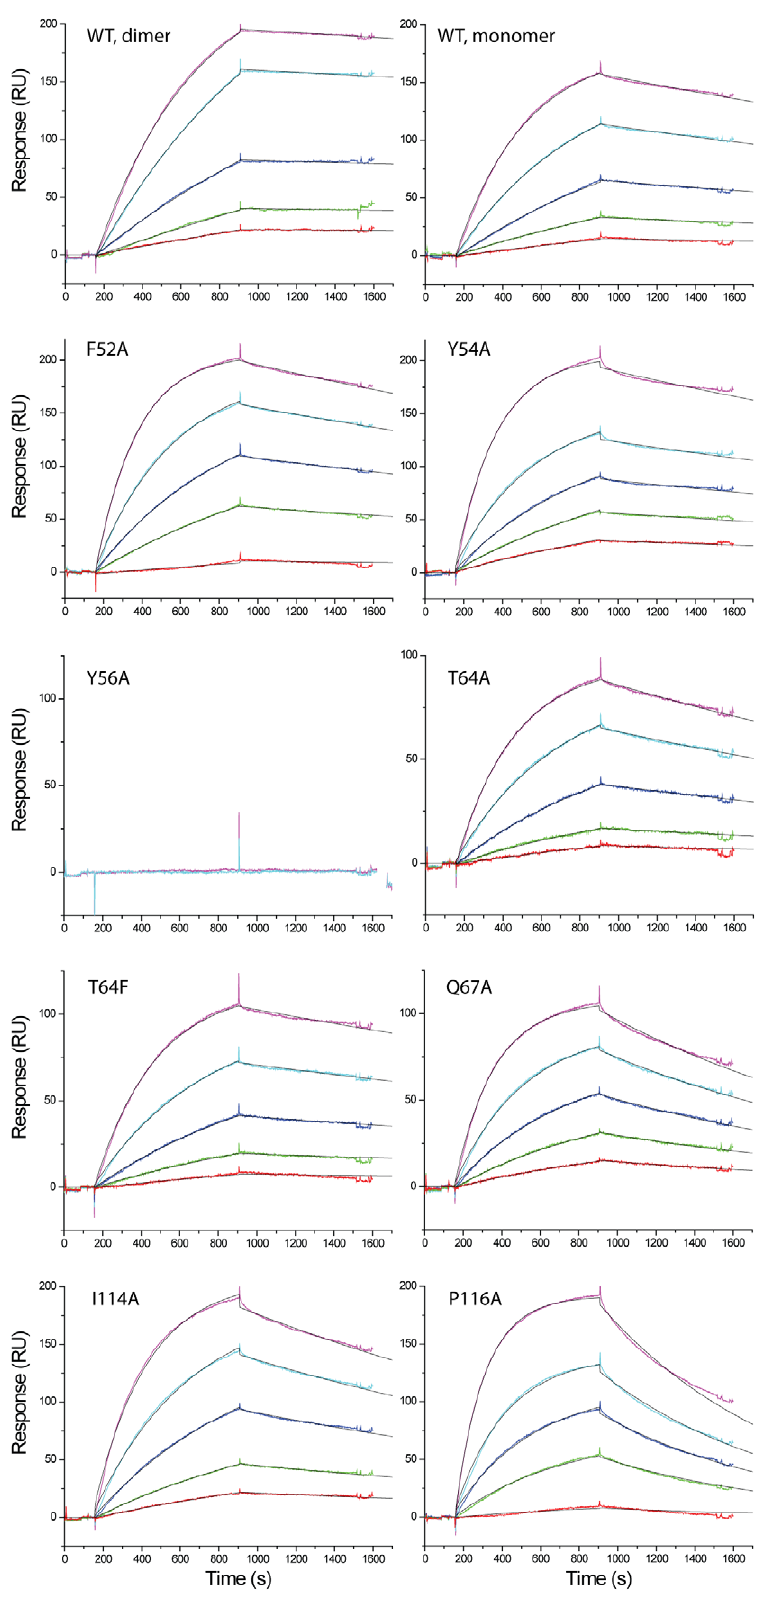
Figure 8. Kinetic analyses of the binding of IL18 with YLDV-IL18BP. SPR analysis was performed as described in Figure 7 with YLDV-IL18BP at 5 different concentrations. The binding curves were globally fitted with BiaEvaluation software to a 1:1 binding model. The colored and black lines are the actual responses in RU and globally fitted curves, respectively.